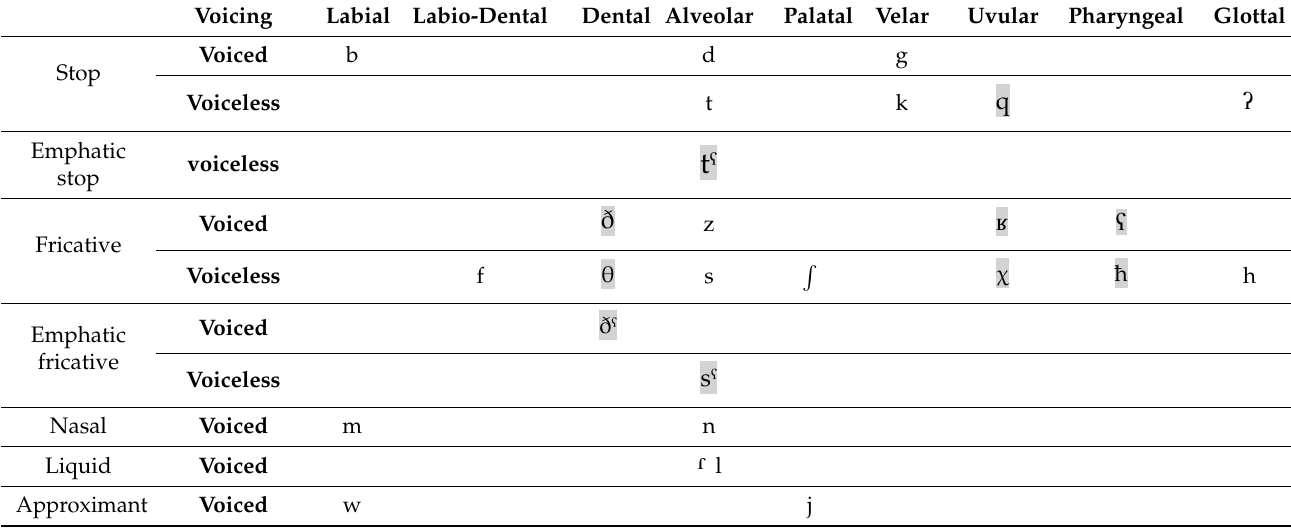
Table 2. The prevalence of CC clusters in the sound systems under investigation. Languages that permit consonant clusters are indicated with the symbol ✓ , while those that do not are indicated with the symbol x.